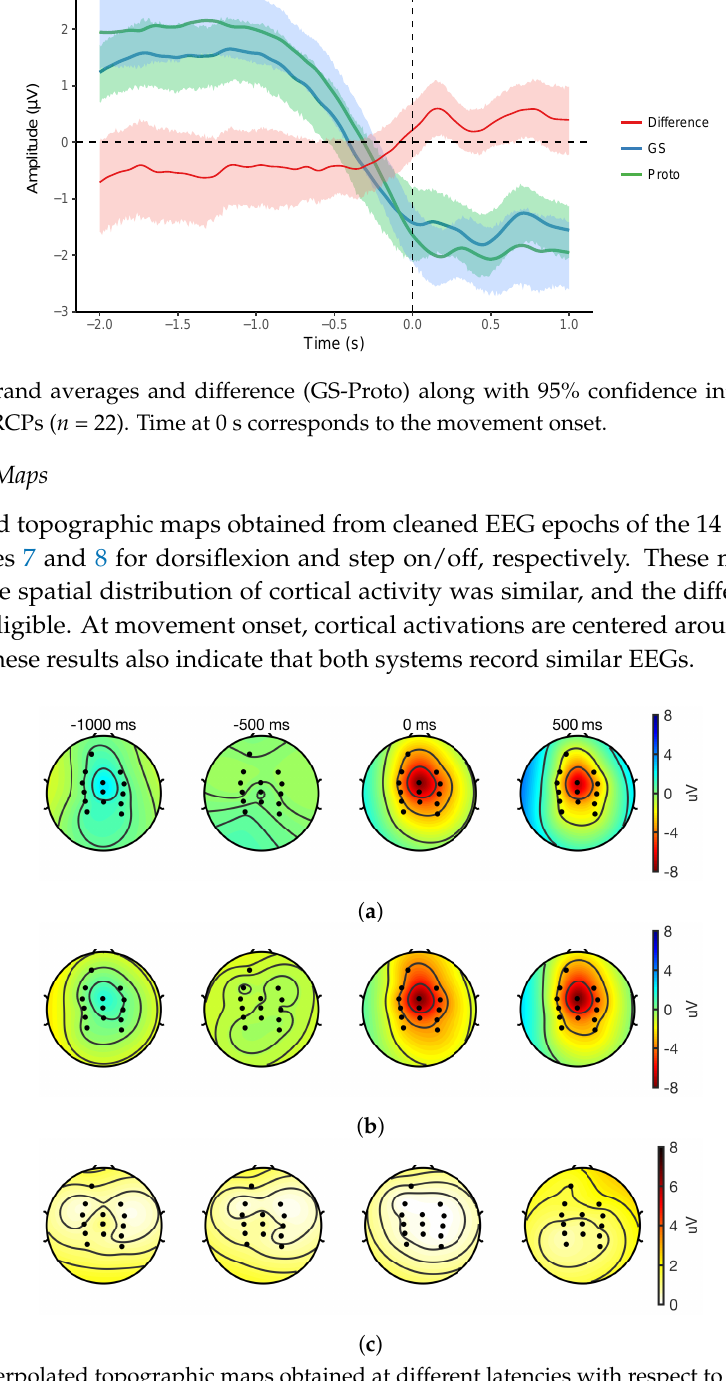
Figure 7. Interpolated topographic maps obtained at different latencies with respect to the movement onset form cleaned EEG epochs ( n = 21); 977 and 1007 epochs were used for the gold standard and the prototype, respectively. Time at 0 ms corresponds to the movement onset. ( a ) GS; ( b ) Proto; ( c ) Absolute difference of channels from ( a ) and ( b